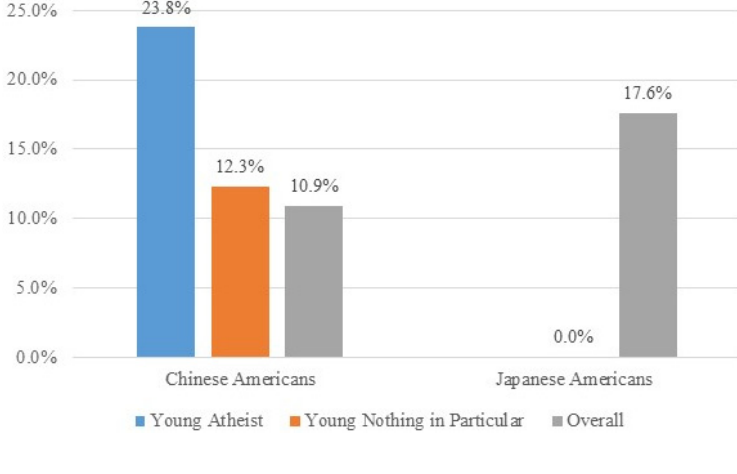
Figure 8. Has home shrine.